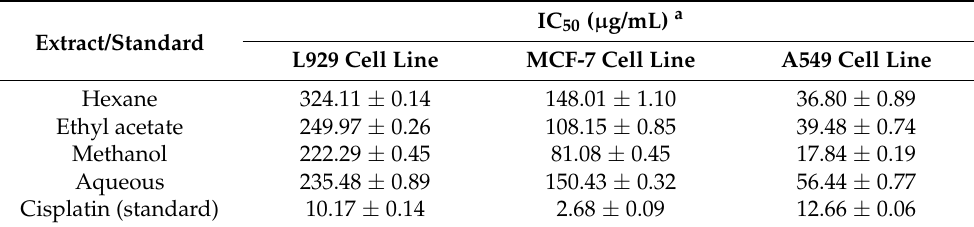
Table 4. IC 50 value ( µ g/mL) of solvent extracts of C. colocynthis against different cell